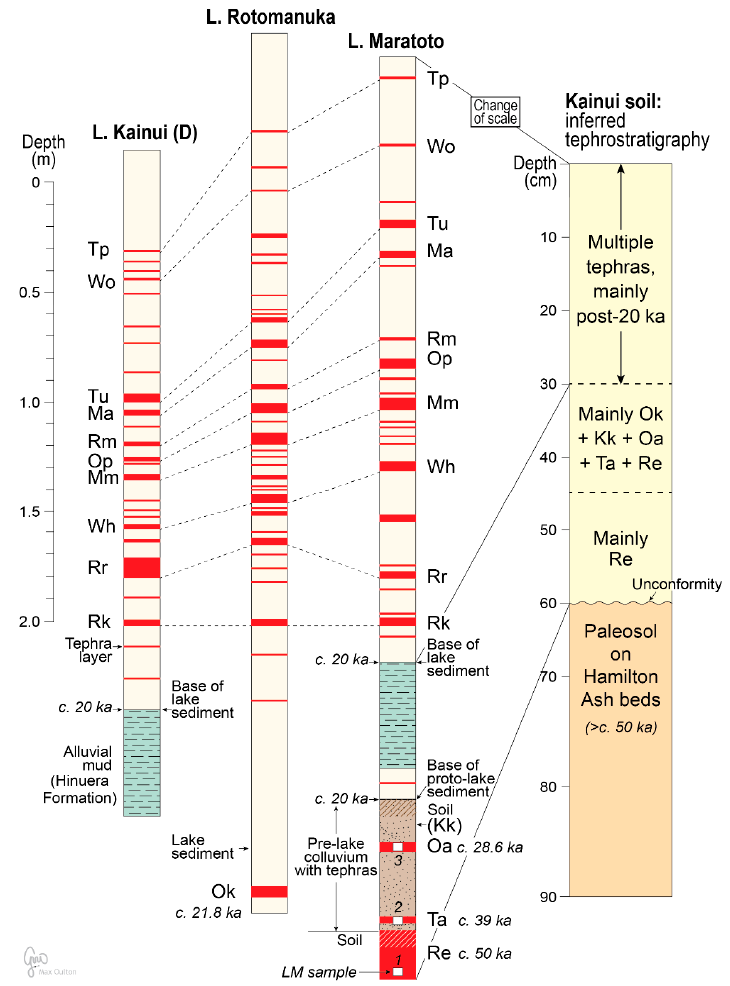
Figure 5. Stratigraphy and correlation of tephra layers in lake sediment cores from lakes Kainui (also known as Lake D), Rotomanuka and Maratoto and underlying pre-lake lithologies and soil horizons (after [36] p. 130–131 and [75] p. 687). Dates (calibrated) on lowermost lake sediments are after [36,75,89]. Named tephras and their approximate calendrical ages, based on [36,76,90,91] are as follows: Tp, Taup ō (1.7 ka or 232 ± 10 CE); Wo, Whakaipo (2.8 ka); Tu, Tuhua (7.5 ka); Ma, Mamaku (8.0 ka); Rm, Rotoma (9.4 ka); Op, Opepe (10.0 ka); Mm, Mangamate (11.3 ka); Wh, Waiohau (14.0 ka); Rotorua (15.6 ka); Rk, Rerewhakaaitu (17.6 ka); Ok, Okareka (21.8 ka); and Kk, Kawakawa (25.4 ka) (not visible as layer). In the lower Lake Maratoto core (core number 4,1i in Reference [75] p. 687), the older tephras (ages shown) are Oa, Okaia; Ta, T ā huna; and Re, Rotoehu. The two buried soil horizons (formed when the deposits were at the land surface) represent disconformities. The column at right depicts the inferred stratigraphy of the Kainui soil. The boundaries of the coverbed tephrostratigraphy are notional because of continuous tephra intermixing (see text).